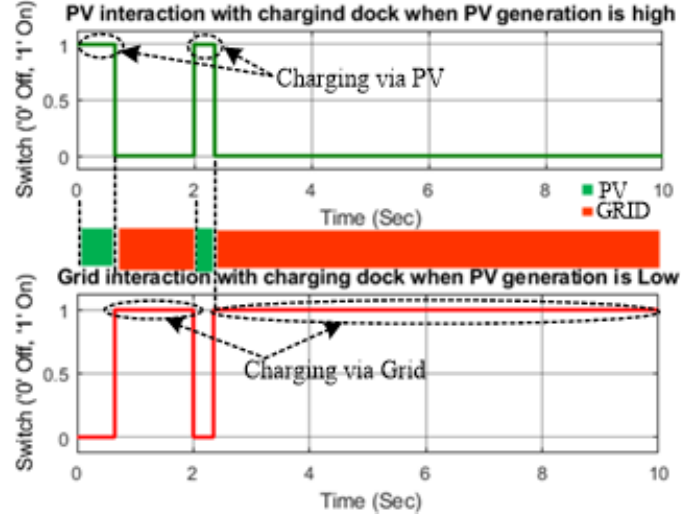
Figure 12. Availability of PV and grid for charging of EVs.